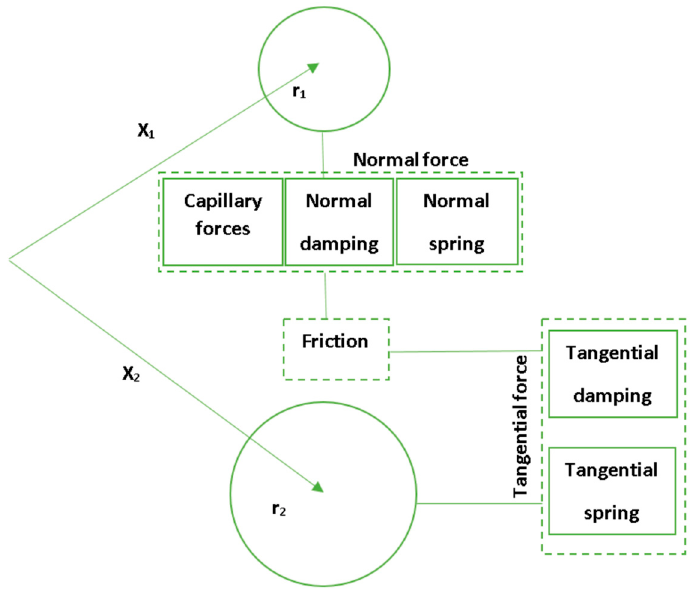
Figure 9. Particle–particle contact interaction with capillary forces.